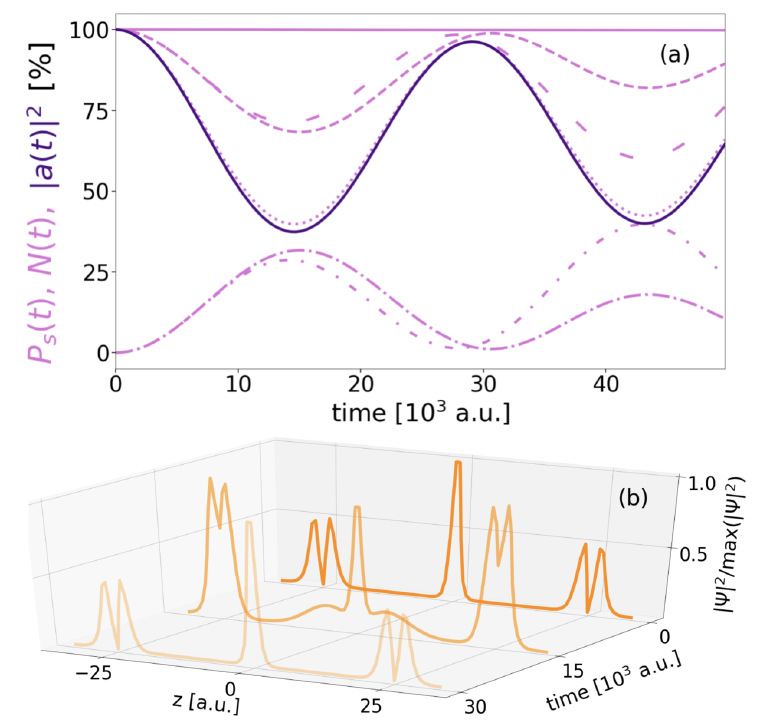
Figure 9. The DE decay’s single-state populations P s ( t ) (light purple, interrupted), as well as the norm N ( t ) (light purple solid) and the squared autocorrelation | a ( t ) | 2 (dark purple solid) as function of time for R AB = 25a.u. in ( a ). The three individual states s examined are A ∗ (dashed), A (dashed- dotted), distinguishable by tight or loose markers for right or left QD, and B (dotted). In ( b ) the normalized electron density distribution | Ψ | 2 / max ( | Ψ | 2 ) is presented for three characteristic time steps of the